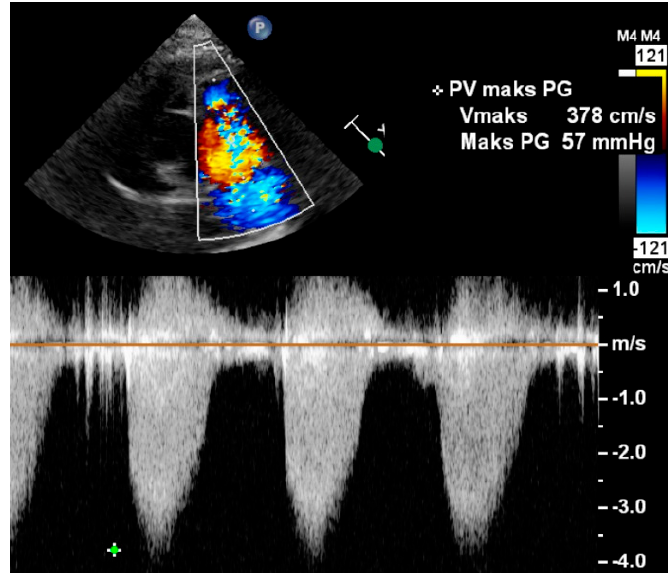
Figure 2. Continuous wave Doppler ultrasound of flow across the pulmonary valve in a patient with pulmonary valve stenosis. Peak pressure gradient (“Maks PG”) shown in upper right corner of the screen was calculated in real-time from peak velocity by using the simplified Bernoulli equation.